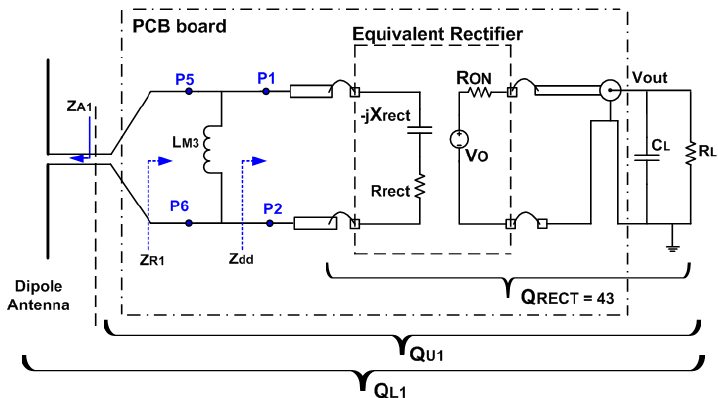
Figure 8. The equivalent circuit of the RFEH system scheme 1.